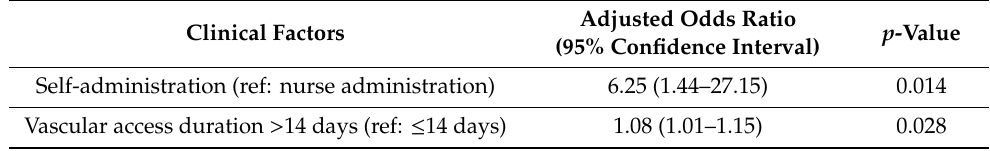
Table 4. Adjusted associations between clinical factors and any adverse event ( n = 86 episodes)